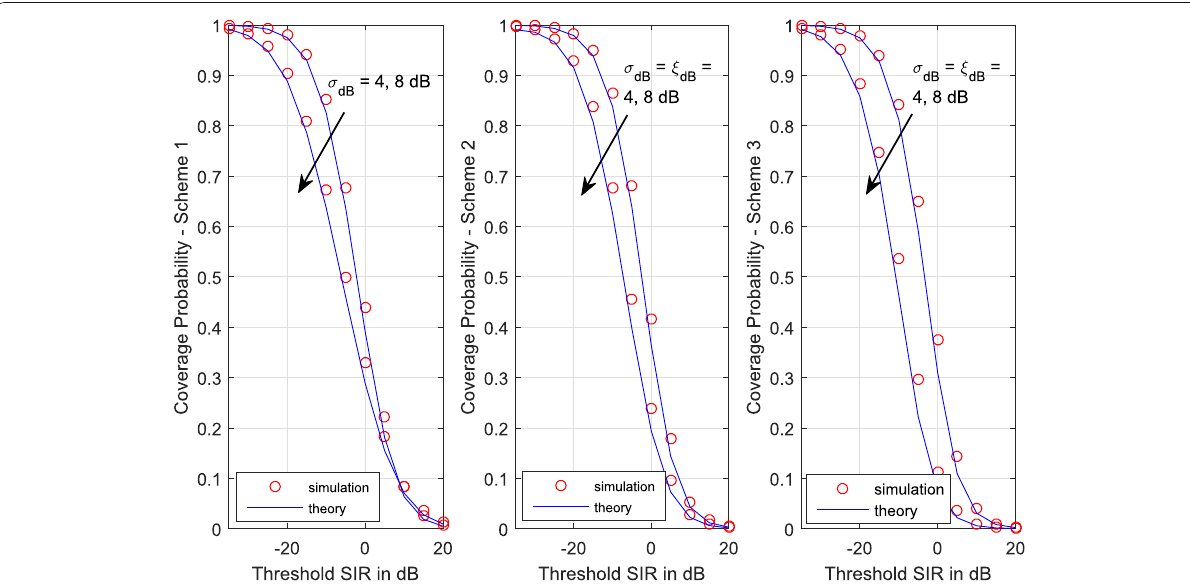
Fig. 1 Coverage probability vs SIR threshold for the three power control schemes under different degrees of shadowing. η = 0.5. λ = 0.5 BSkm − 2 , α = 3.5